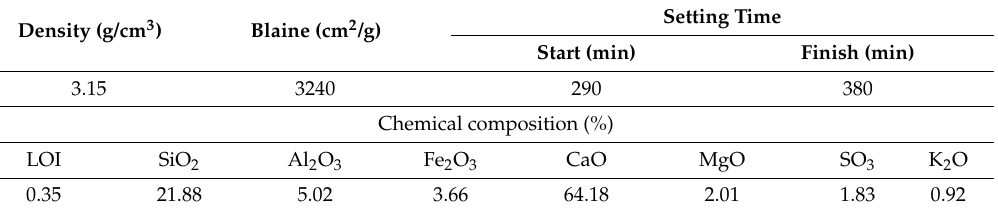
Table 2. Physical and chemical properties of ordinary Portland cement